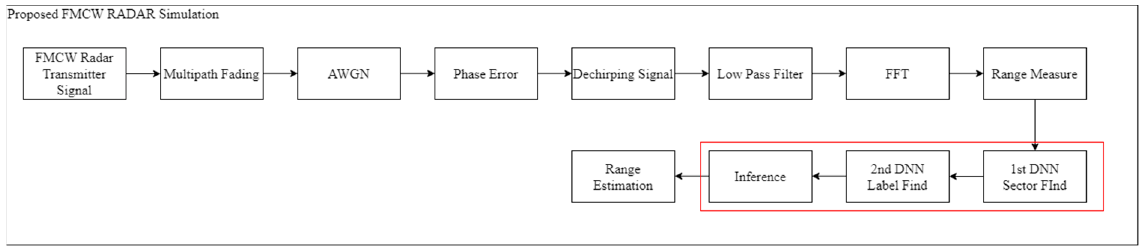
Figure 11. MATLAB Simulation Block Diagram.(red box: the module proposed in this work) Table 4. MATLAB simulation environment . Table 4. MATLAB simulation